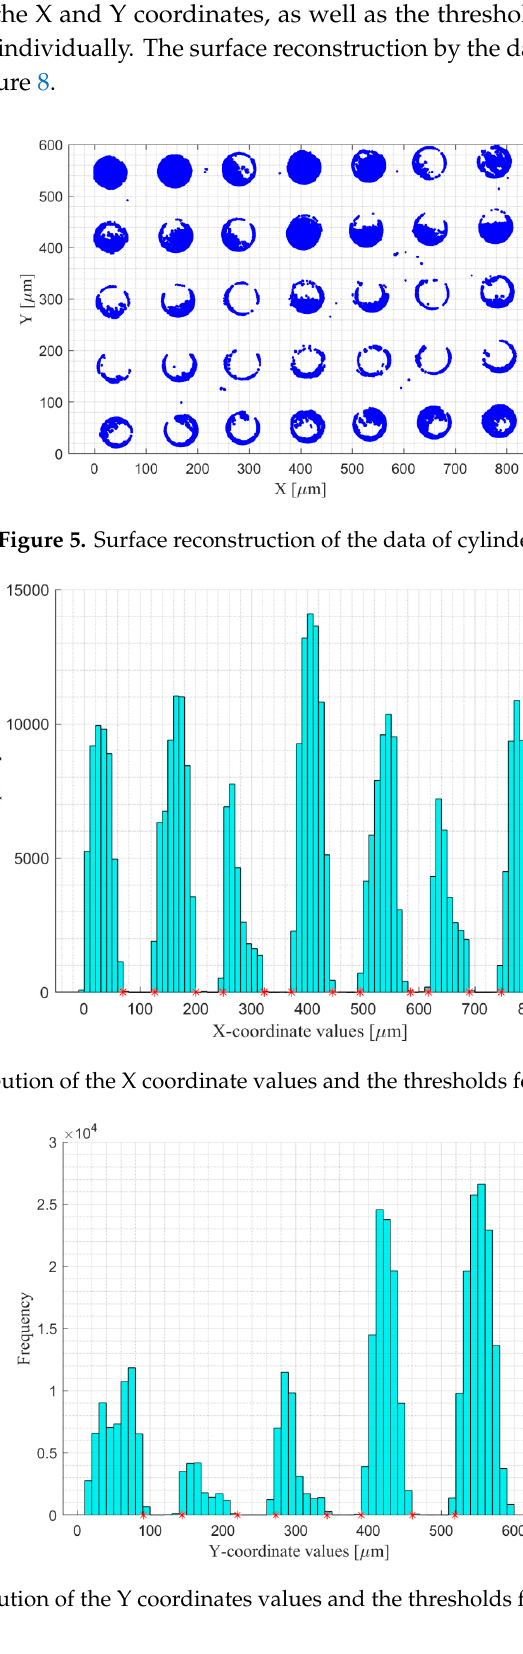
Figure 4. Histograms of the X, Y, and Z coordinates of the aligned surface.